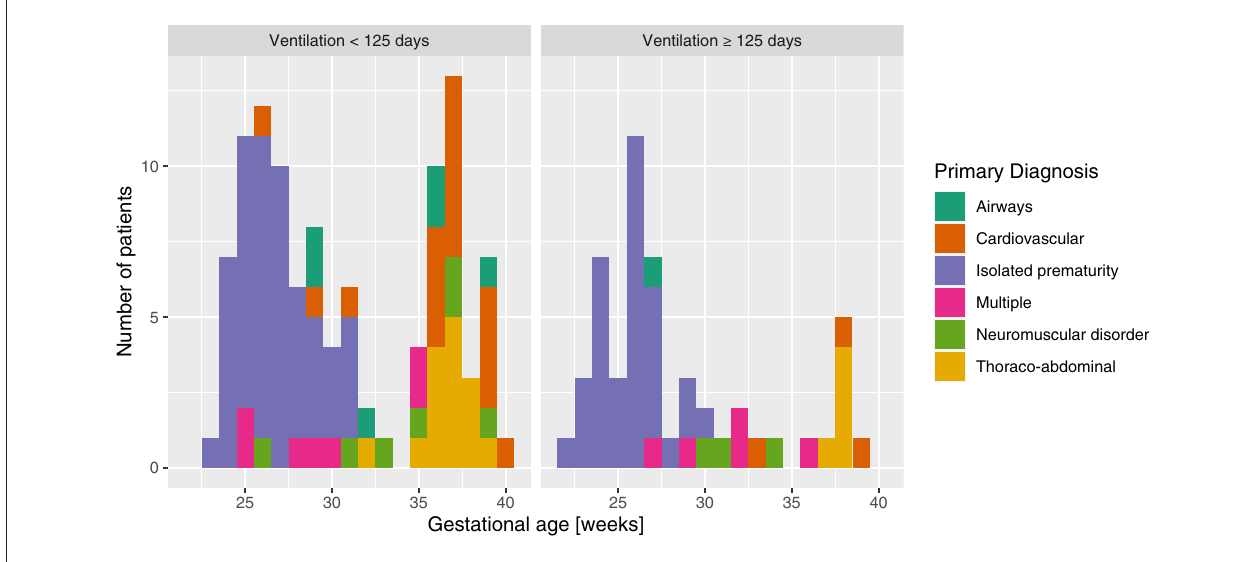
FIGURE 1 | Primary diagnosis categories distributed per gestational age.